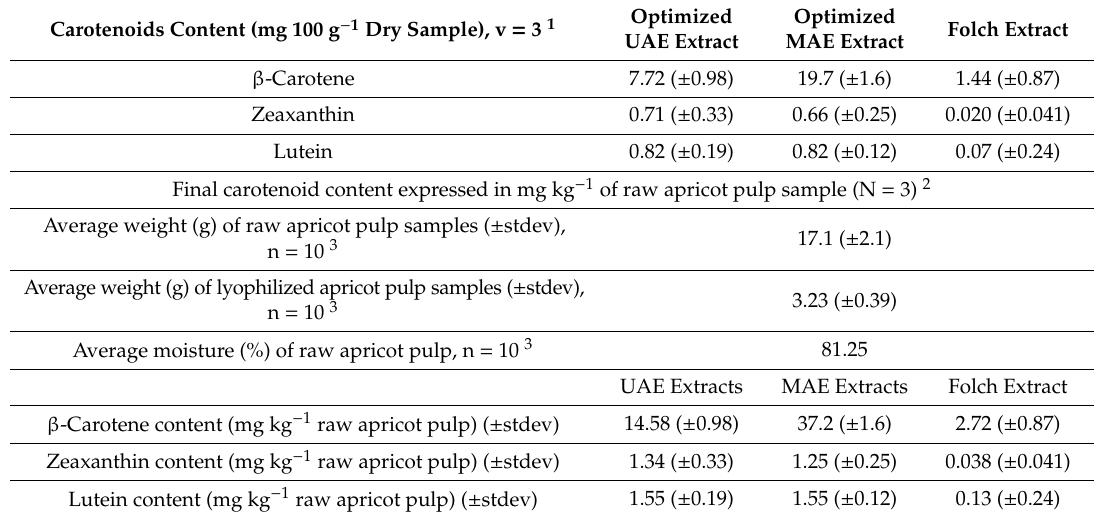
Table 2. Carotenoid content of apricot pulp determined by LC-MS /